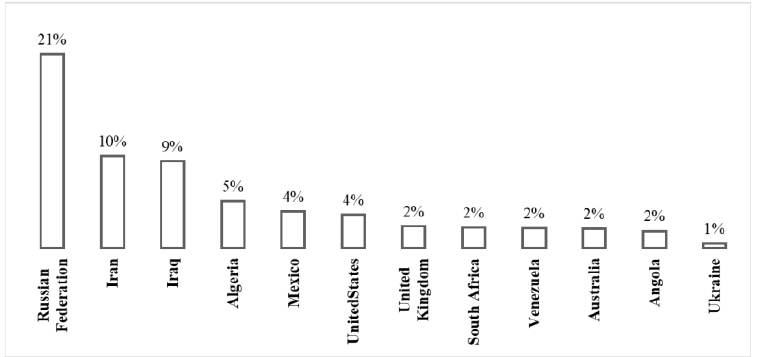
Figure 4. The worldwide countries including the greatest number of detected gas flares. Each percentage indicates the ratio of the national detections over the total detected gas flares (i.e., 1711).